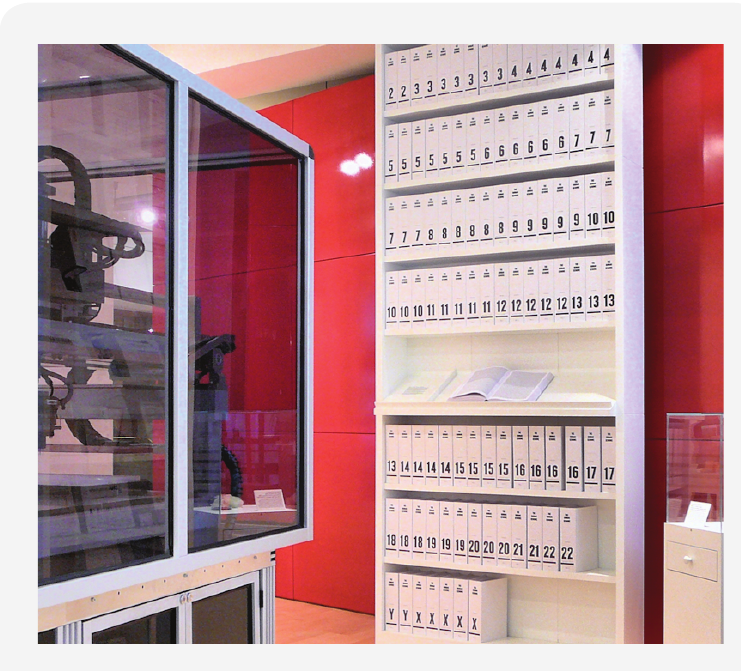
Figure 3. The Human Genome Catalog, Cambridge University. Source: the Sanger Center.